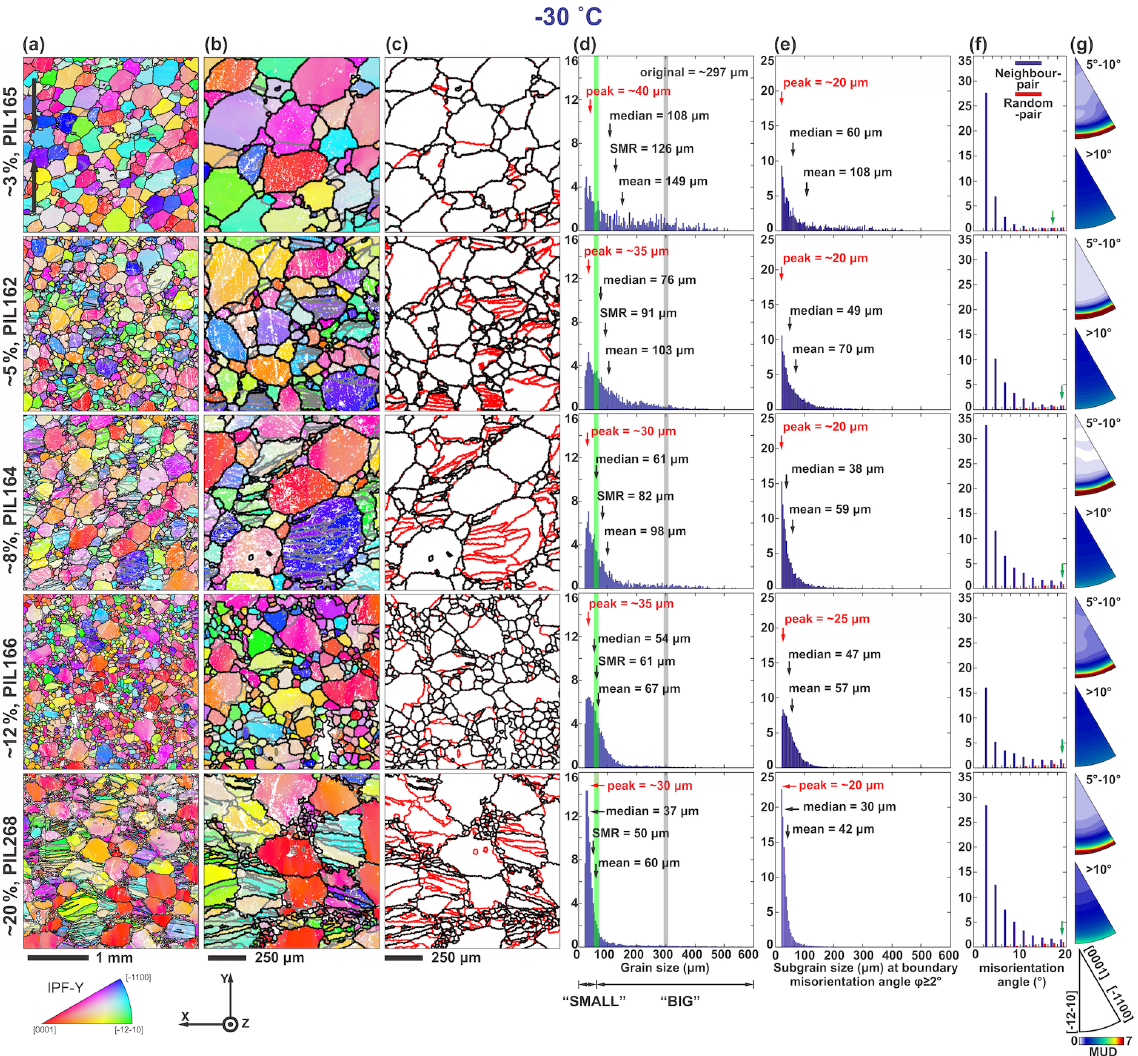
Figure 6. Microstructural analyses of deformed ice samples at − 30 ◦ C. Axial true strain increases from ∼ 3% on top to ∼ 20% on the bottom. The descriptions of columns (a) to (g) are the same as in Fig.